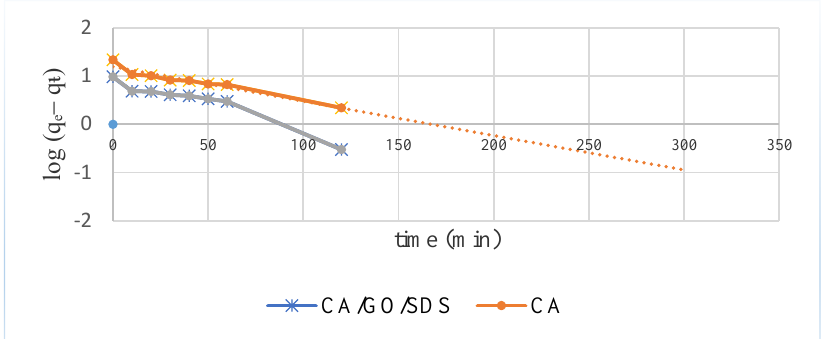
Figure 5. The adsorption kinetics of phosphate adsorption by CA and CA/GO/SDS for the pseudo- first-order model .